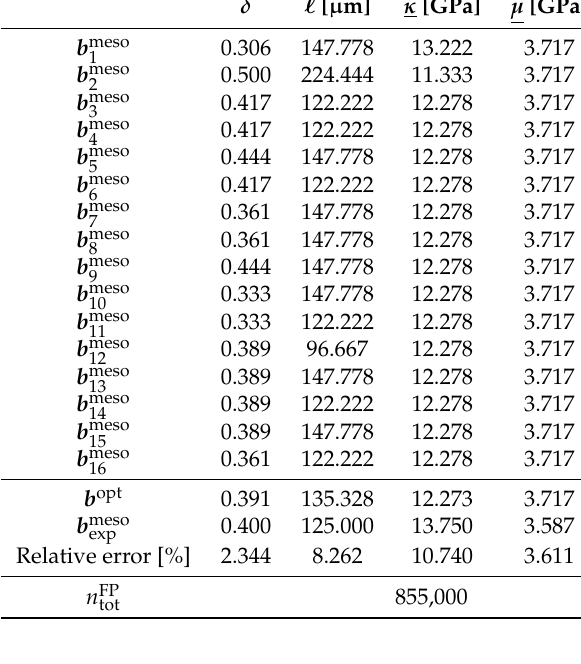
Table 2 are equal to the same identified value 3.717 GPa, the probability density function p M does not correspond to the Dirac measure on R at point 3.717 GPa but to a gamma distribution with a very small dispersion around this value, since for the prior probabilistic model of H = ( K , M ) considered here, K and M cannot be deterministic variables (see Section 9). We finally obtain the global optimal value b opt = ( 0.391, 135.328, 12.273, 3.717 ) in ([ − ] , [ µ m ] , [ GPa ] , [ GPa ]) with relative errors less than 3%, 9%, 11% and 4% for δ opt , (cid:96) opt , κ opt and µ opt , respectively, with respect to the reference experimental